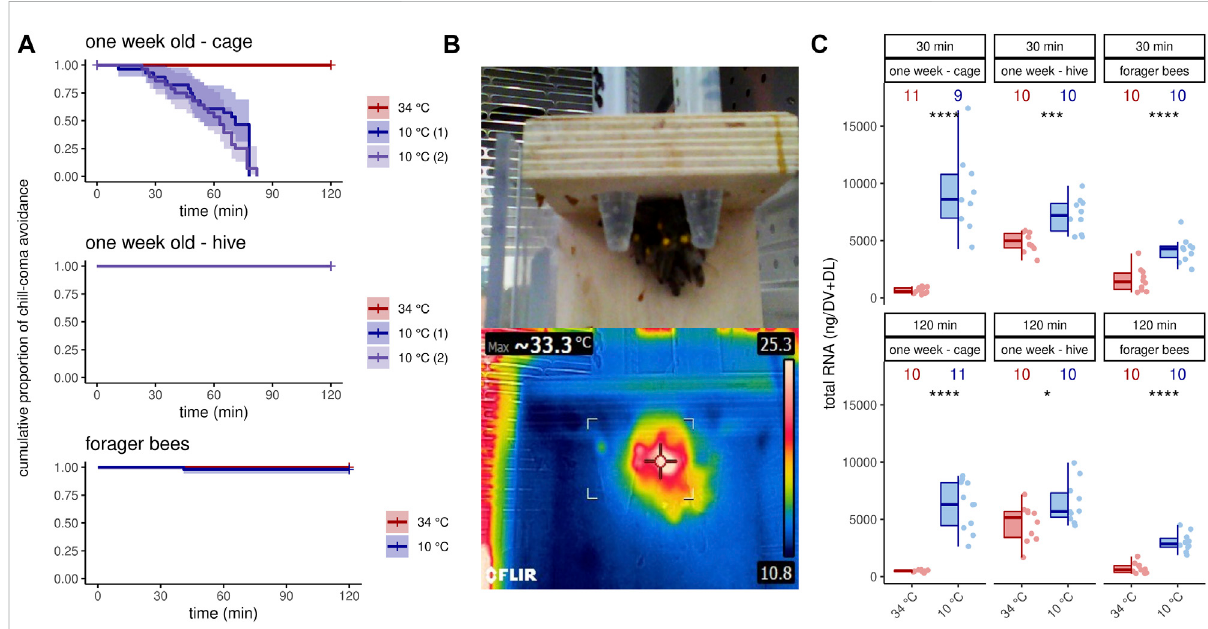
FIGURE 1 Workerbeesresponddifferentlytocoldstress. (A) Oneweekoldworkerbeesfromcagesarenotabletowithstand2 hoursofcoldstresswithout falling into chill coma (log rank test χ 2 (2) = 76.1, p ≤ 0.0001, N 34 ° C = 32, N 10 ° C (1) = 30, N 10 ° C (2) = 31). Both 10 ° C groups displayed a recovery rate of 100%. Not a single 1 week old workerbee from hives went into chill coma ( N 34 ° C = 31, N 10 ° C (1) = 30, N 10 ° C (2) = 30). When forager bees were cold stressedover120 min,onlyonebeefeltintochillcoma(logranktestq 2 (1)=1, p =0.3, N 34 ° C =48, N 10 ° C =50). (B) Workerbeesthatsuccessfully survive 2 hours of cold stress form a cluster in which they effectively perform thermogenesis. (C) The RNA total amount signi fi cantly increases in workerbee fl ight muscles due to cold stress ( t -test, 1 week - cage - 30 min: t (8.07) = − 7.20, p = 0.0005; 1 week - cage - 120 min: t (10) = − 8.84, p = 0.035; 1 week - hive - 30 min: t (14.3) = − 4.26, p = 0.0005; 1 week - hive - 120 min: t (17.7) = − 2.28, p = 0.035; forager - 30 min: t (17.9) = − 5.30,